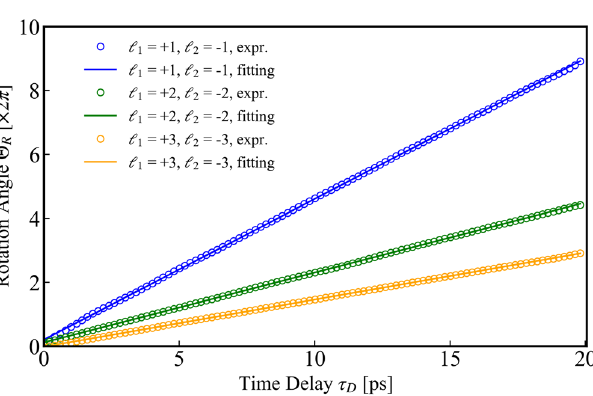
Figure 2. Ultrafast ring-shaped optical lattice rotation by the superposition of two chirped p with topological charge pairs of ℓ 1 and ℓ 2 . The time-divided spatial patterns of SFG recorded on the CMOS camera at the nominal time delay τ D between the generated pulse and the reference pulse of 0.00, 0.20, 0.40. petal are guide for the eye. Experimental and simulated results are respectively at the top and bottom in ( a–c ).